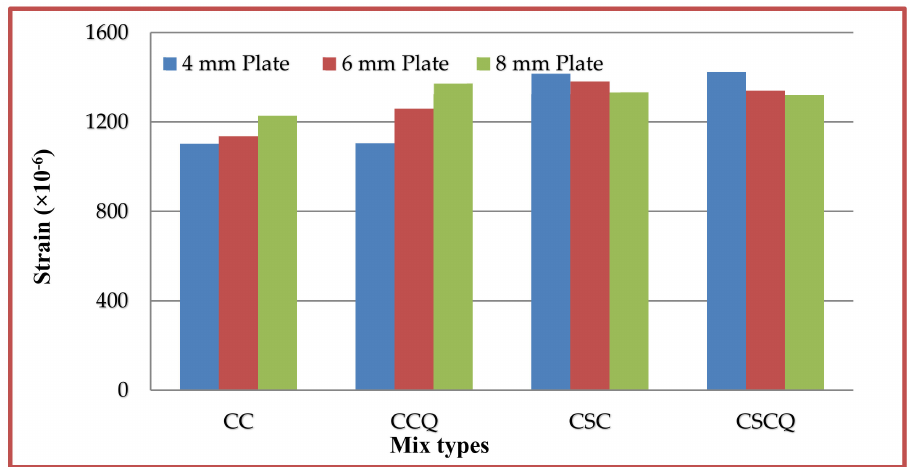
Figure 23. Bottom tension plates strains of di ff erent mixes.